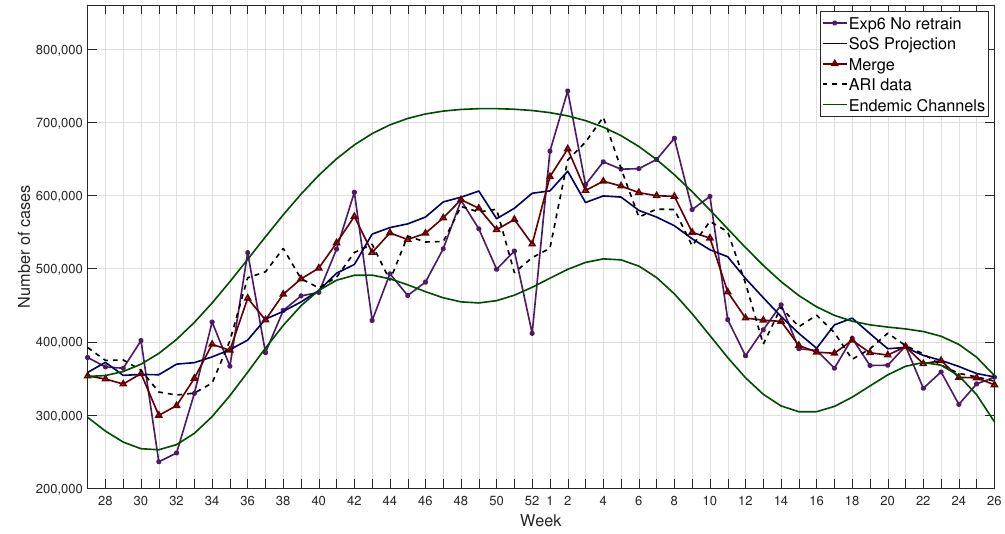
Figure 12. Example of all results from the model for the year 2017–2018 compared with the real values for ARI